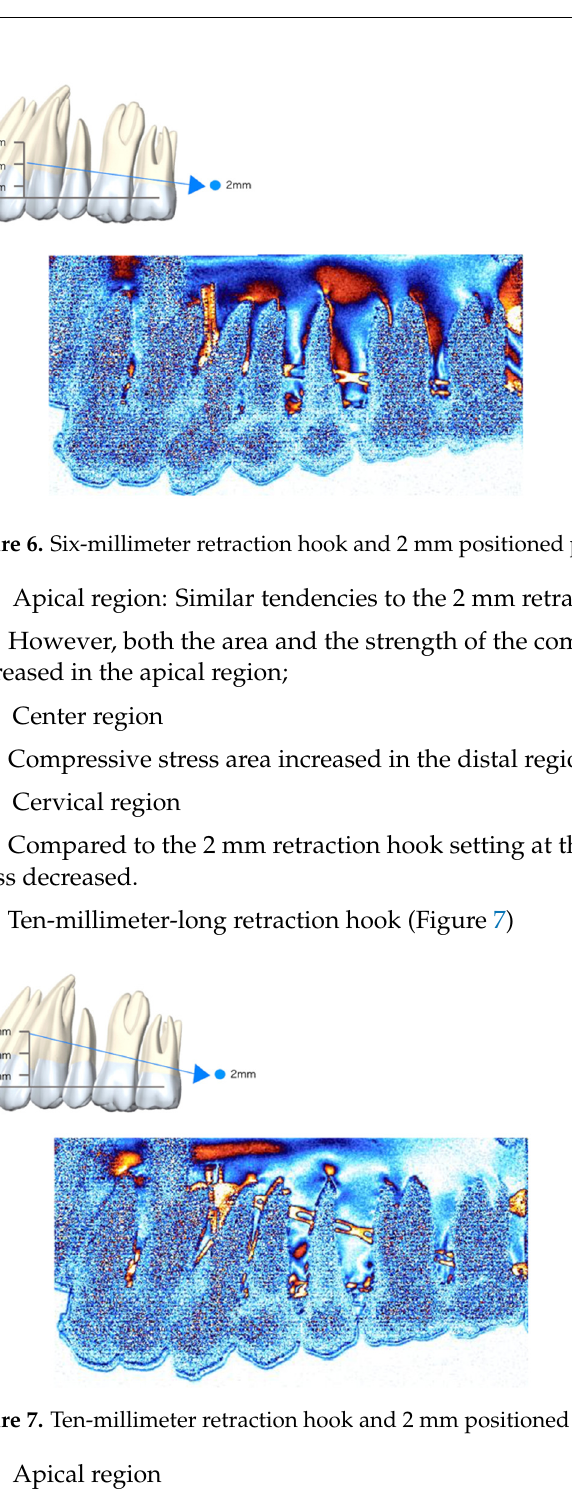
5 of 11 Figure 5. Two-millimeter retraction hook and 2 mm positioned posterior anchor model. • Six-millimeter-long retraction hook (Figure 6) (a) Apical region: Similar tendencies to the 2 mm retraction hook were observed. However, both the area and the strength of the compressive stress were remarkably decreased in the apical region;